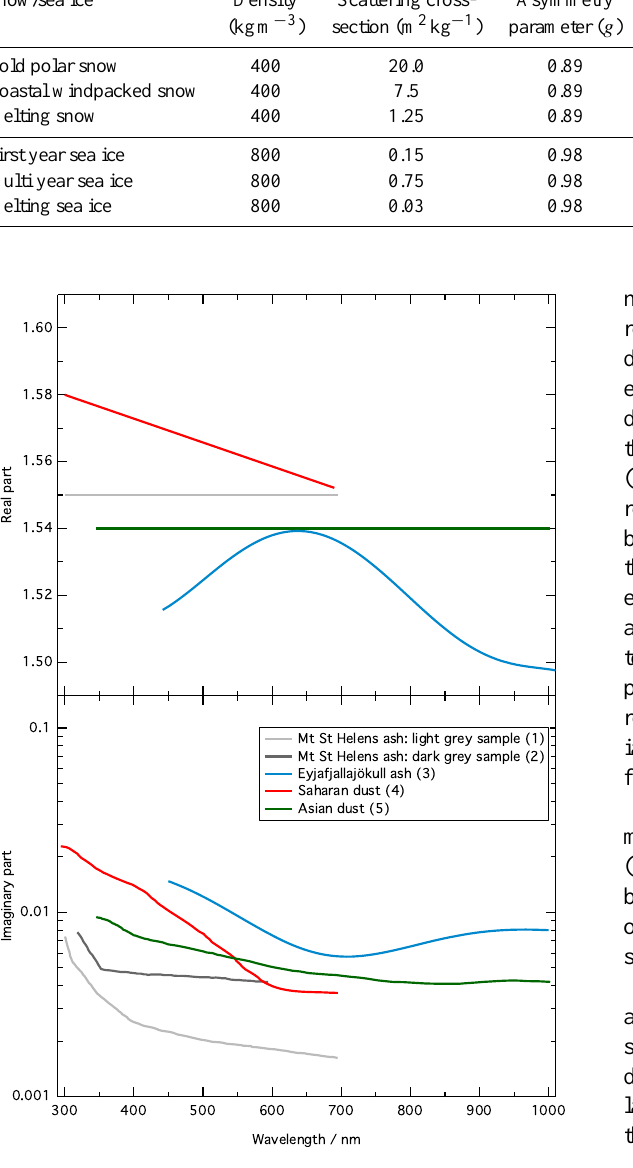
airborne Saharan aerosols from eight locations in the Atlantic ocean (Patterson and Gillette,